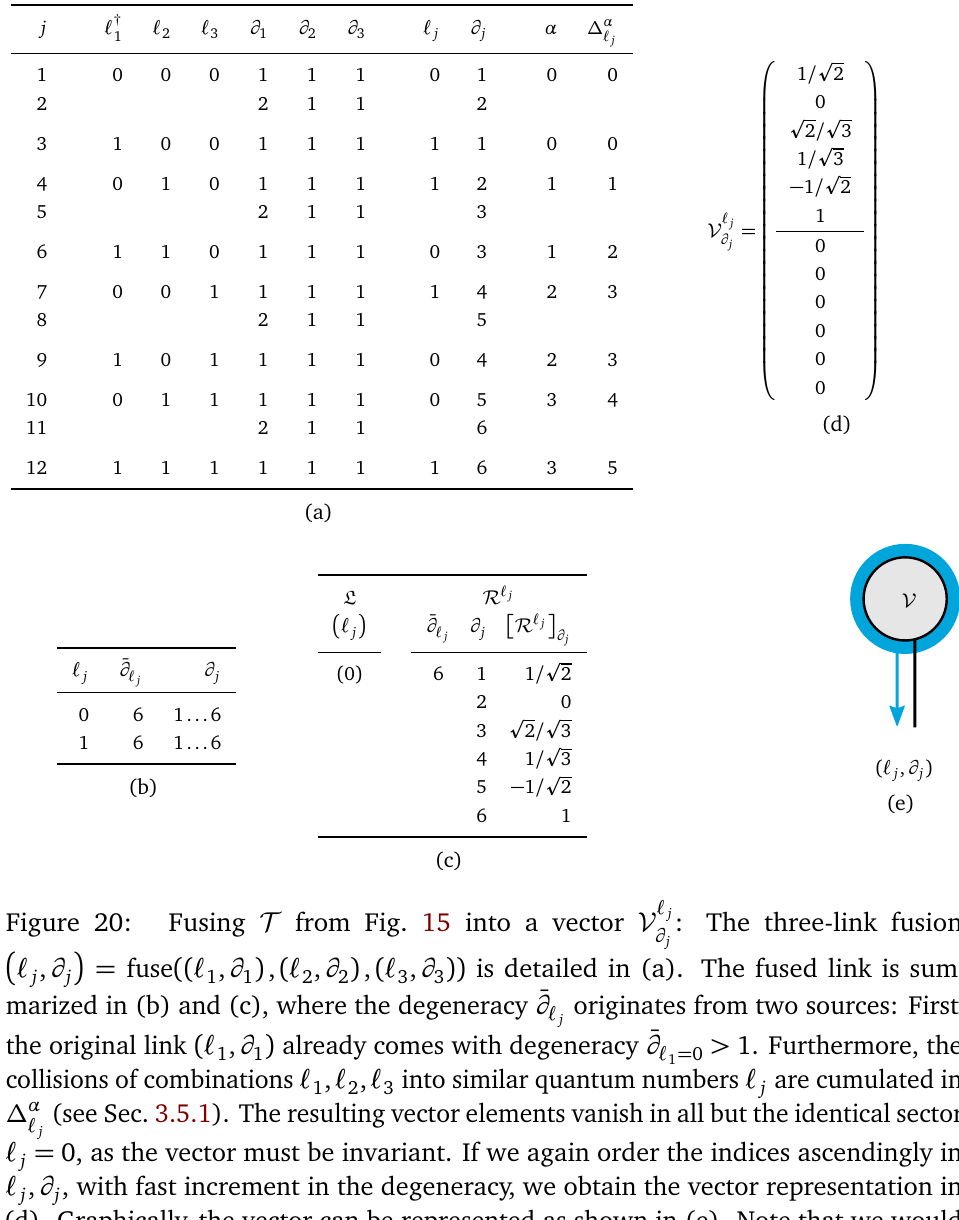
(cid:96) j Figure 20: Fusing T from Fig. 15 into a vector V : The three-link fusion ∂ j (cid:0) (cid:96) (cid:1) = ) , ( (cid:96) ) , ( (cid:96) )) is detailed in (a). The fused link is sum- , ∂ fuse (( (cid:96) , ∂ , ∂ , ∂ j j 1 1 2 2 3 3 marized in (b) and (c), where the degeneracy ¯ ∂ (cid:96) originates from two sources: First, j ) already comes with degeneracy ¯ ∂ > 1. Furthermore, the the original link ( (cid:96) , ∂ (cid:96) = 0 1 1 1 collisions of combinations (cid:96) , (cid:96) , (cid:96) into similar quantum numbers (cid:96) are cumulated in j 1 2 3 ∆ α (see Sec. 3.5.1). The resulting vector elements vanish in all but the identical sector (cid:96) j (cid:96) = 0, as the vector must be invariant. If we again order the indices ascendingly in j (cid:96) , ∂ , with fast increment in the degeneracy, we obtain the vector representation in j j (d). Graphically, the vector can be represented as shown in (e). Note that we would ) and ( (cid:96) ) at the matrix M have obtained the same result by fusing links ( (cid:96) , ∂ , ∂ a a b b from Fig. 19, as link fusions can be